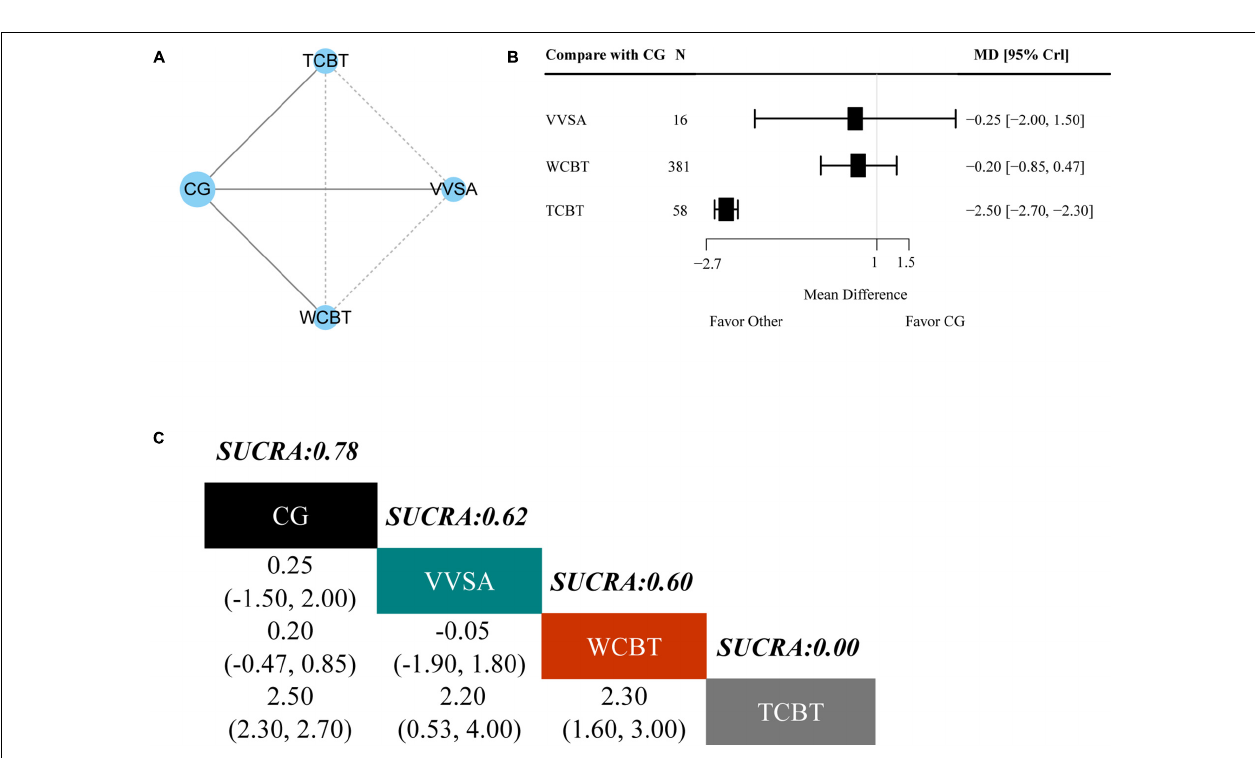
FIGURE 5 | Results of the network meta-analysis for K-6. (A) Network geometry of eligible comparisons for K-6. (B) Forest plot of the network meta-analysis compared with control group. (C) Ranking of each intervention based on the SUCRA values and the league table for the relative effects of all treatments. TCBT, telephone-based cognitive behavioral treatment; WCBT, web-based cognitive behavioral treatment; VVSA, video viewing smartphone application; CG, control group; SUCRA, surface under the cumulative ranking curve; MD, weighted mean difference; CrI, credible interval.